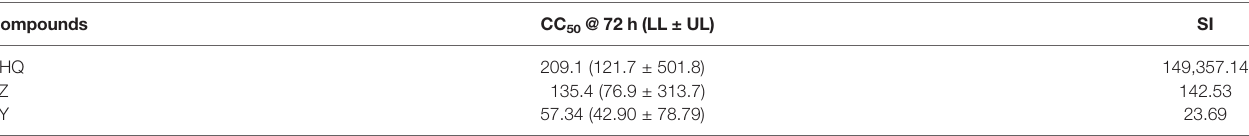
DataarereportedasmeansIC 50s plusSDofthreeindependentexperimentsperformedintriplicateeach.hTERTcells(6.0×10 4 cells/ml)weregrownfor24h,andnon-adherentcellswere washed away. Microplate wells were treated with 100-µl volume of compounds (DHQ, SZ, and PY) as described in the anti-parasitic assay for uniformity purposes. The 50% minimum cytotoxicconcentrationsofthehTERTcellsweredetermined.PriortotheCC 50s calculations,theconcentrationswereconvertedtologandplottedagainstthepercentviabilityofhostcells usingaGraphPadPrism.DHQ(dihydroquinine;currentcompoundstudied)SZ(sulfadiazine),andPY(pyrimethamine)aretheprimaryknowndrugsusedincombinationforthetreatmentof Toxoplasma gondii infection. IC 50 is the minimum concentration that will inhibit 50% of T. gondii parasites ’ growth. CC 50 (minimal cytotoxic concentration that will kill 50% of host cells) is presented astriplicatedetermination(n=3).SI(selectivityindex) isdetermined by(CC 50@72h /IC 50@72h )interactionofcompoundshostcells/parasites.(LL±UL),whereLLislowerlimitand UP is upper